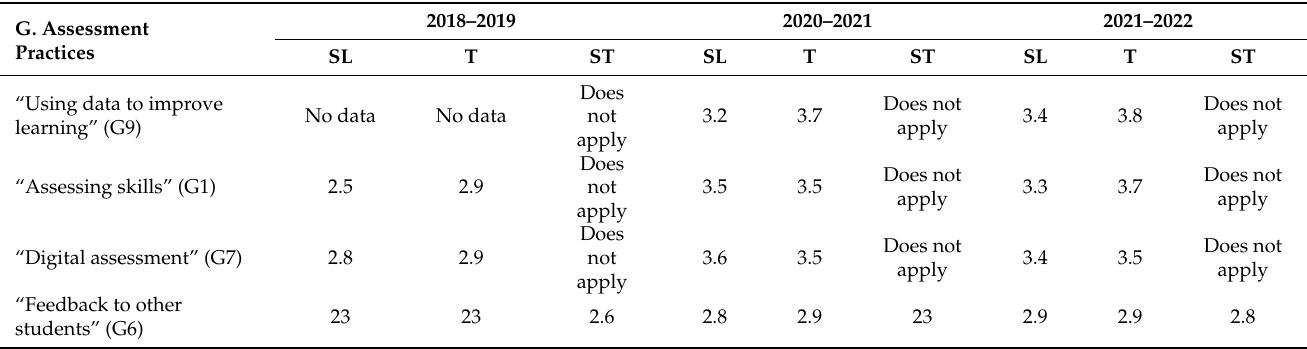
Table 8. Descriptive statistics on Assessment